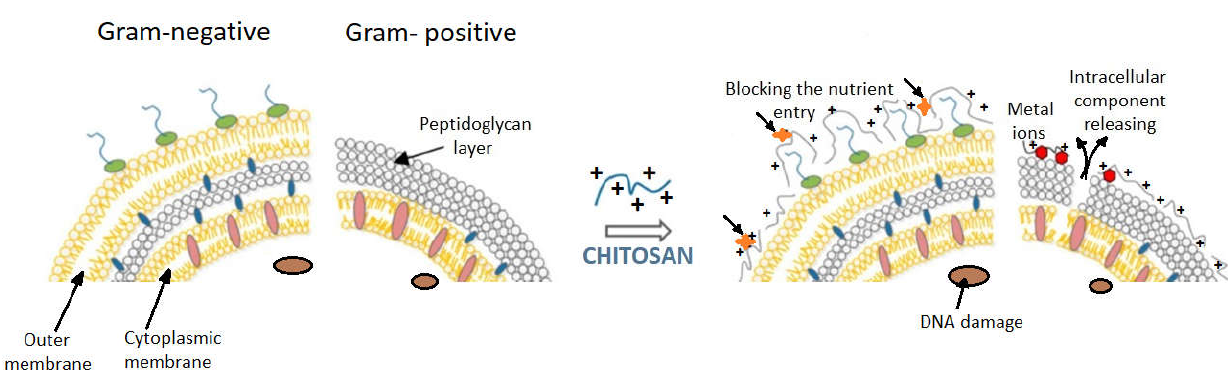
Figure 7. Models proposed for chitosan action upon Gram-positive and Gram-negative bacteria (from Kravanja et al., 2019 [55]).